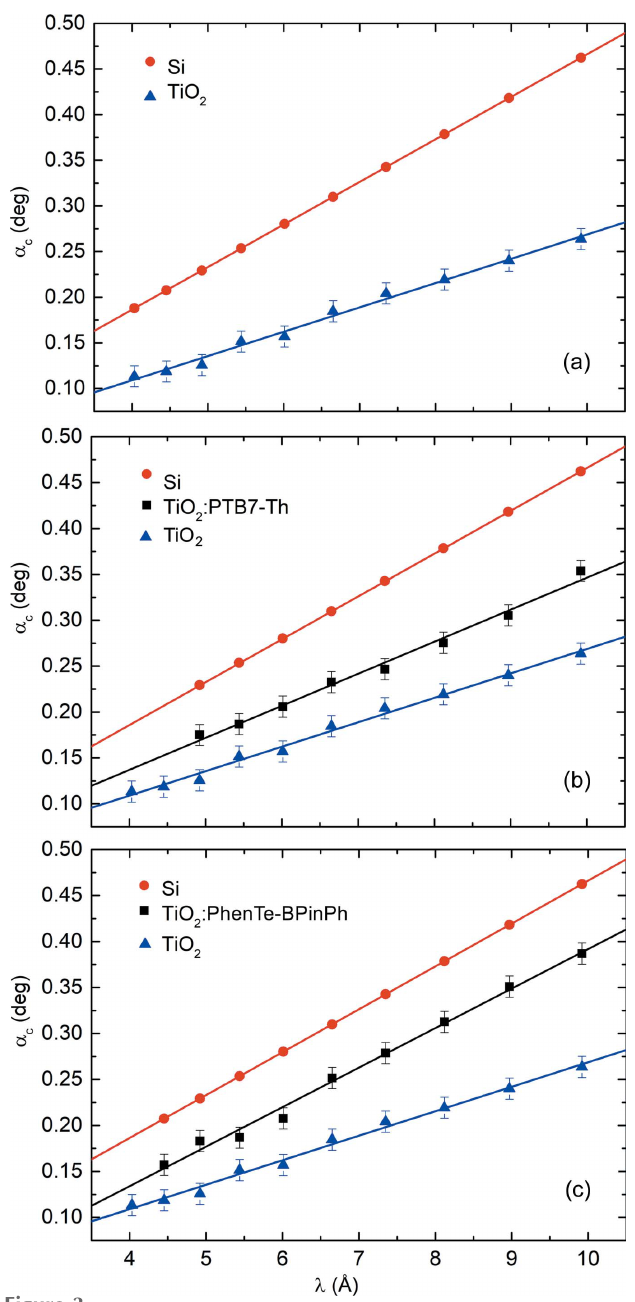
Figure 3 Linear regressions of material-specific critical angles obtained from vertical line cuts of ToF-GISANS data versus neutron wavelength for ( a ) as-prepared mesoporous titania, ( b ) mesoporous titania filled with PTB7- Th and ( c ) mesoporous titania filled with PhenTe-BPinPh. As indicated in the inset, different colors correspond to linear regressions related to the SLDs of Si (red) and TiO 2 [TiO 2 : PTB7-Th (blue) and TiO 2 : PhenTe- BPinPh (black)] composite